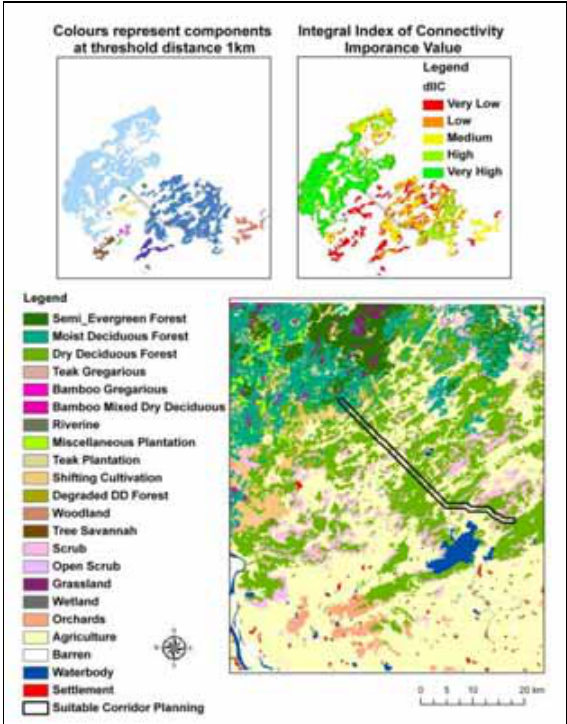
Figure 5: Shortest Path analysis using ACO and Table showing the percentage area of the vegetation